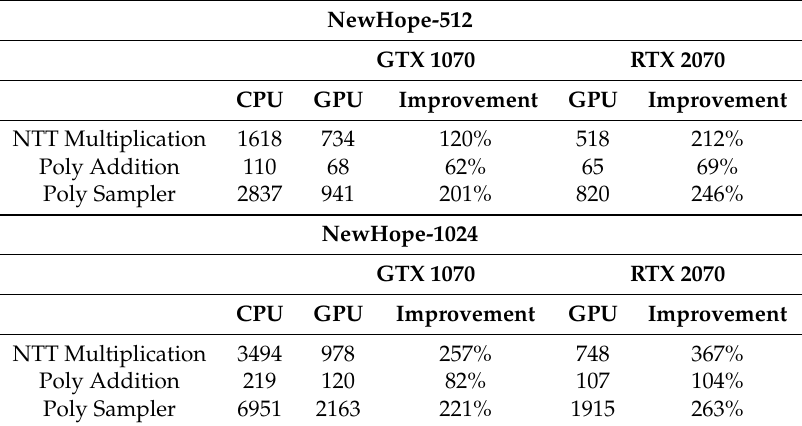
Table 12. Operation time ( µ s) and performance improvements by optimized major operation in NewHope.